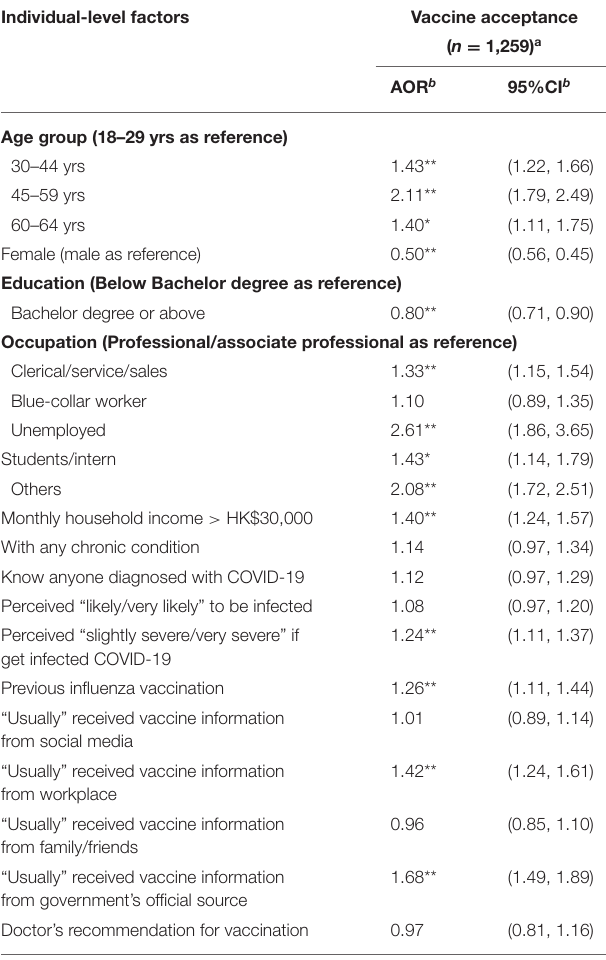
TABLE 5 | The association between individual-level factors and vaccine acceptance among those accepted at least one of the DCE choice tasks. Individual-level